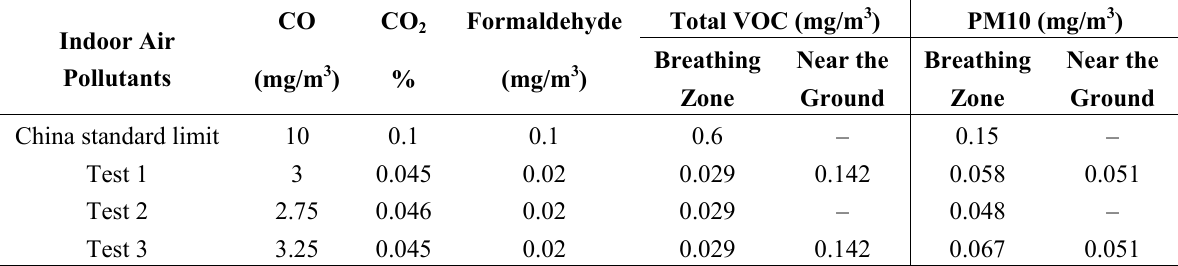
Table 7. The test data of indoor pollutant concentration. Source: China’s National Indoor Air Quality Standard GB 18883-2002 [12].